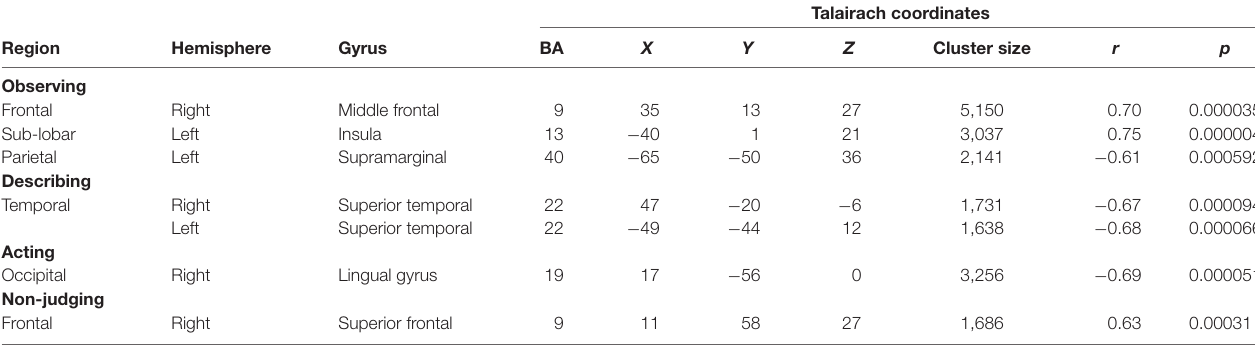
Talairach coordinates